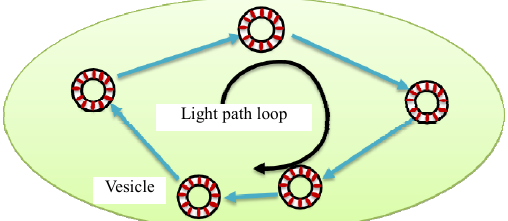
Fig. 7 Multiple scattering mechanism diagram